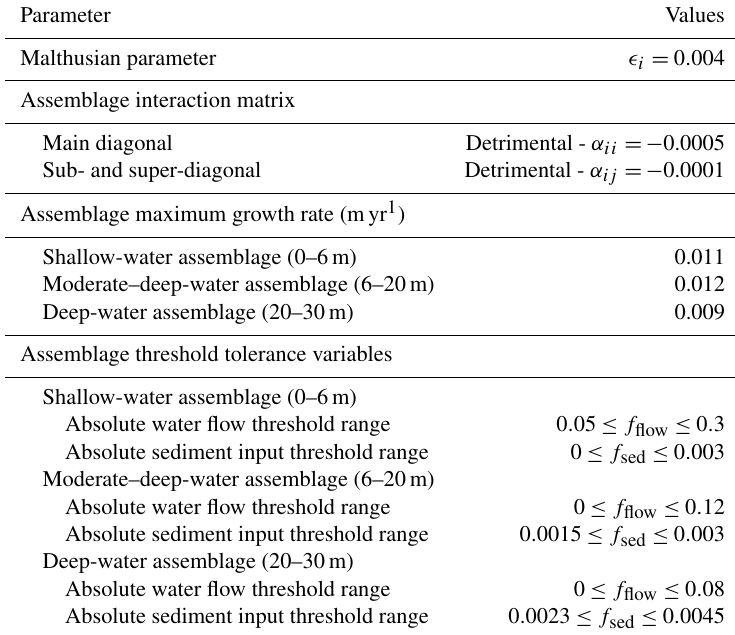
Table 2. Parameter values used in our two experiments. Estimates of maximum production rates for assemblages were determined based on literature surveys of maximum growth rates for coral facies of GBR (Davies and Hopley, 1983) and Indo-Pacific reefs (Montaggioni,